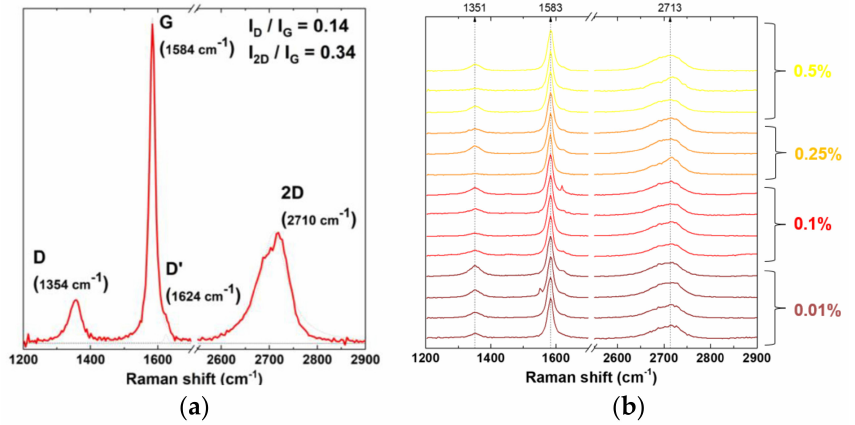
Figure 4. Raman spectroscopy analysis: ( a ) Raman spectra of pristine graphene powder; ( b ) Raman spectra of graphene present in the four concentrations of reinforced